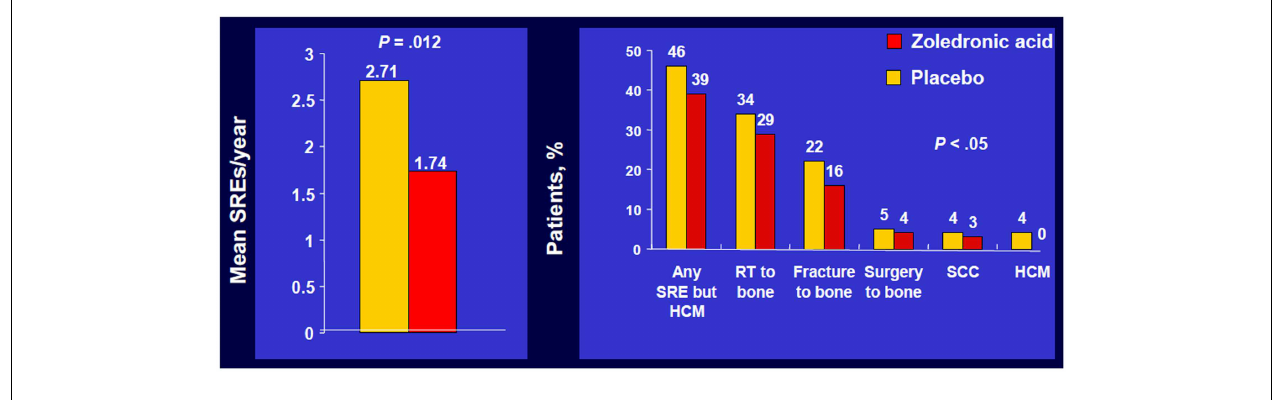
SRE, skeletal-related event; mets, metastases; NSCLC, non-small cell lung cancer; OST, other solid tumors; RT, radiotherapy; SCC, spinal cord compression; HCM, hypercalcemia of malignancy. Data from Rosen et al.